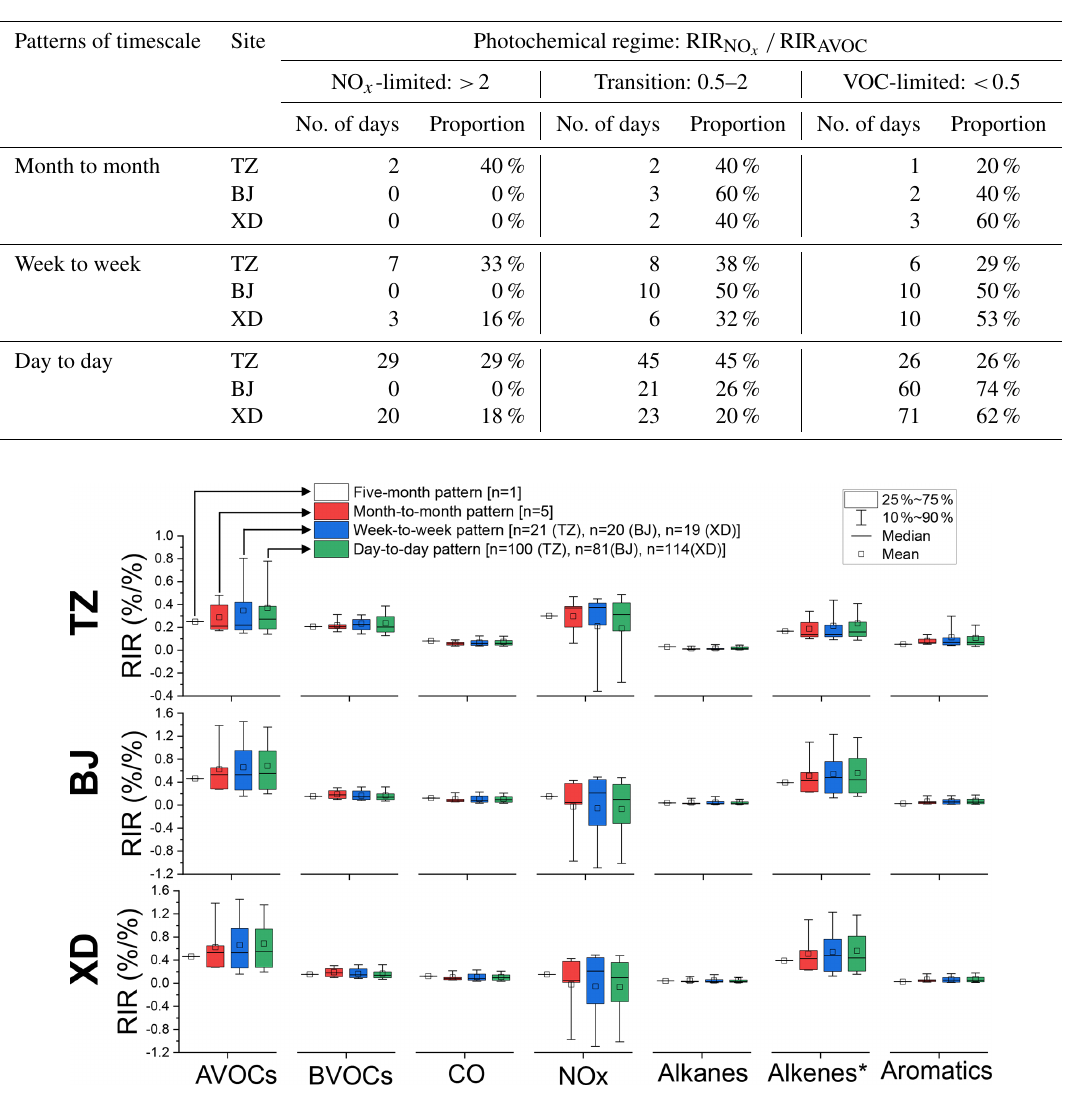
Table 2. Summary of the number of days (for model calculation) and proportions that were classified into the three photochemical regimes across each site and multiple patterns of timescale.